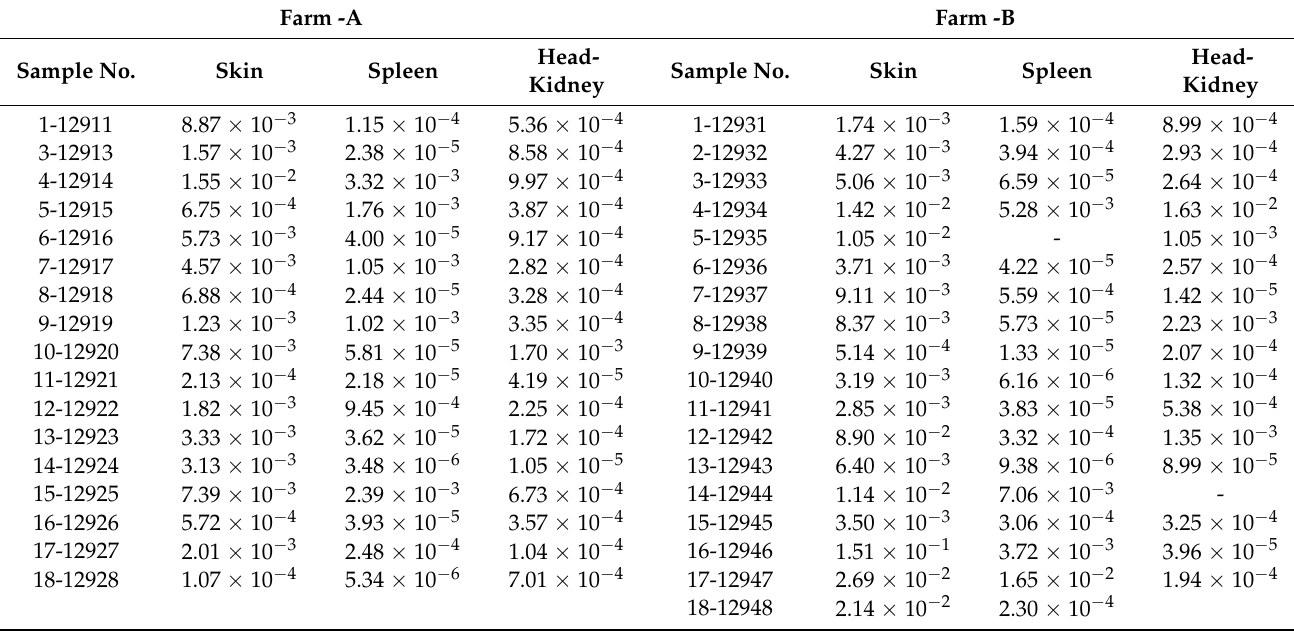
Table 3. Quantitative PCR to detect the MLO Copy number of two RMS positive farms and one negative farm in fish tissues based on 16SrDNA/igf1 x 1000 ratio. Farm -A Farm